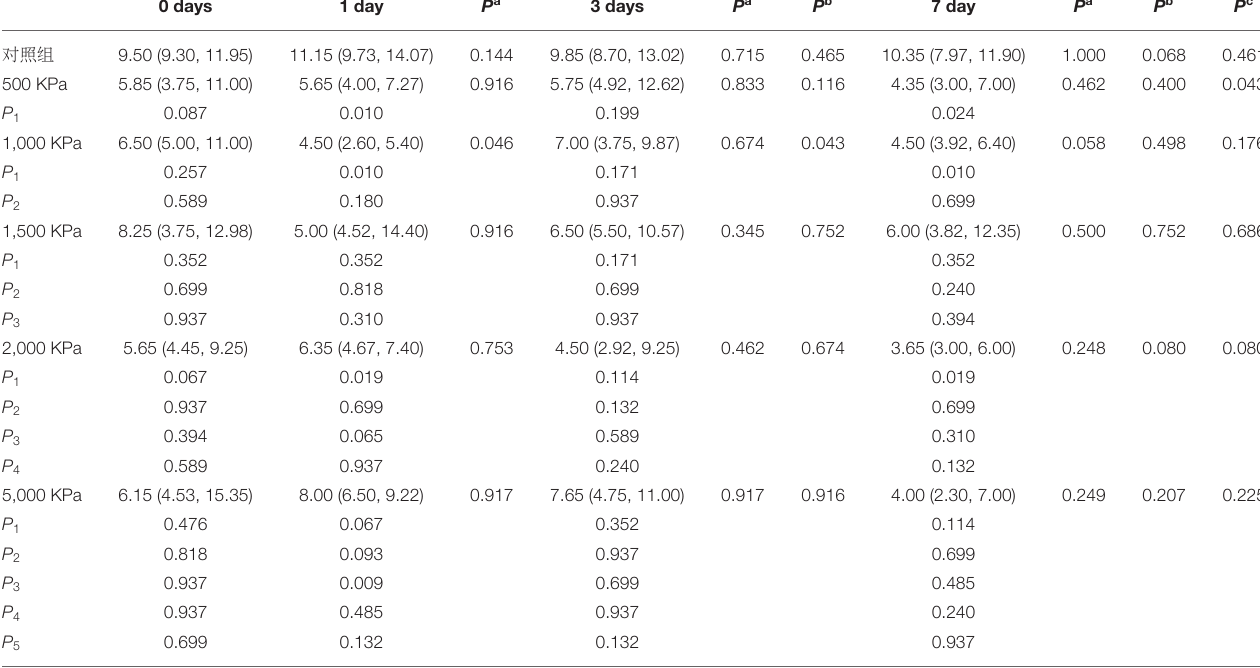
TABLE 1 | Values of IOP in different groups (Median and